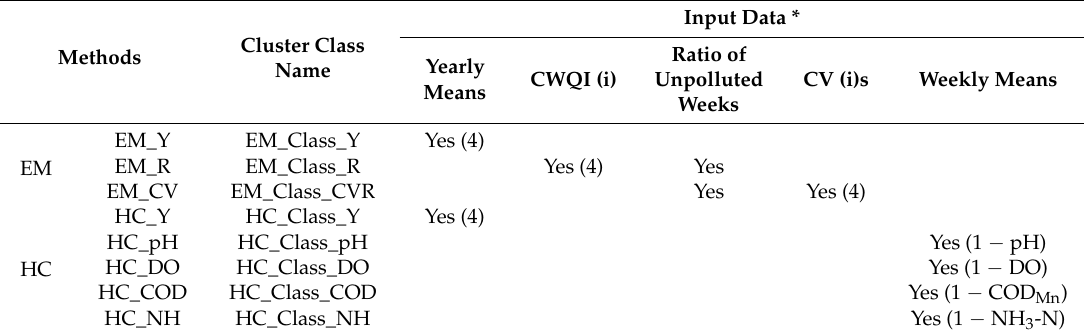
Methods of three expectation-maximization (EM) algorithms and five hierarchical agglomerative cluster (HC)